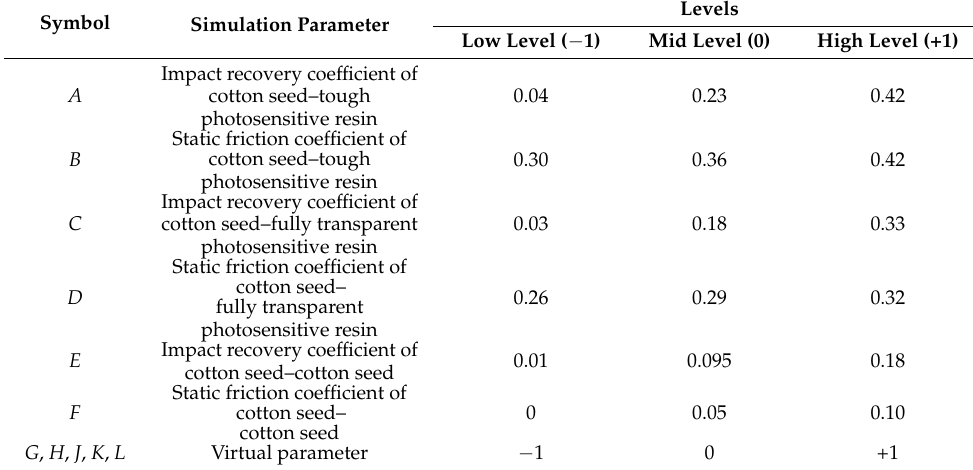
Table 2. Plackett–Burman test parameter range